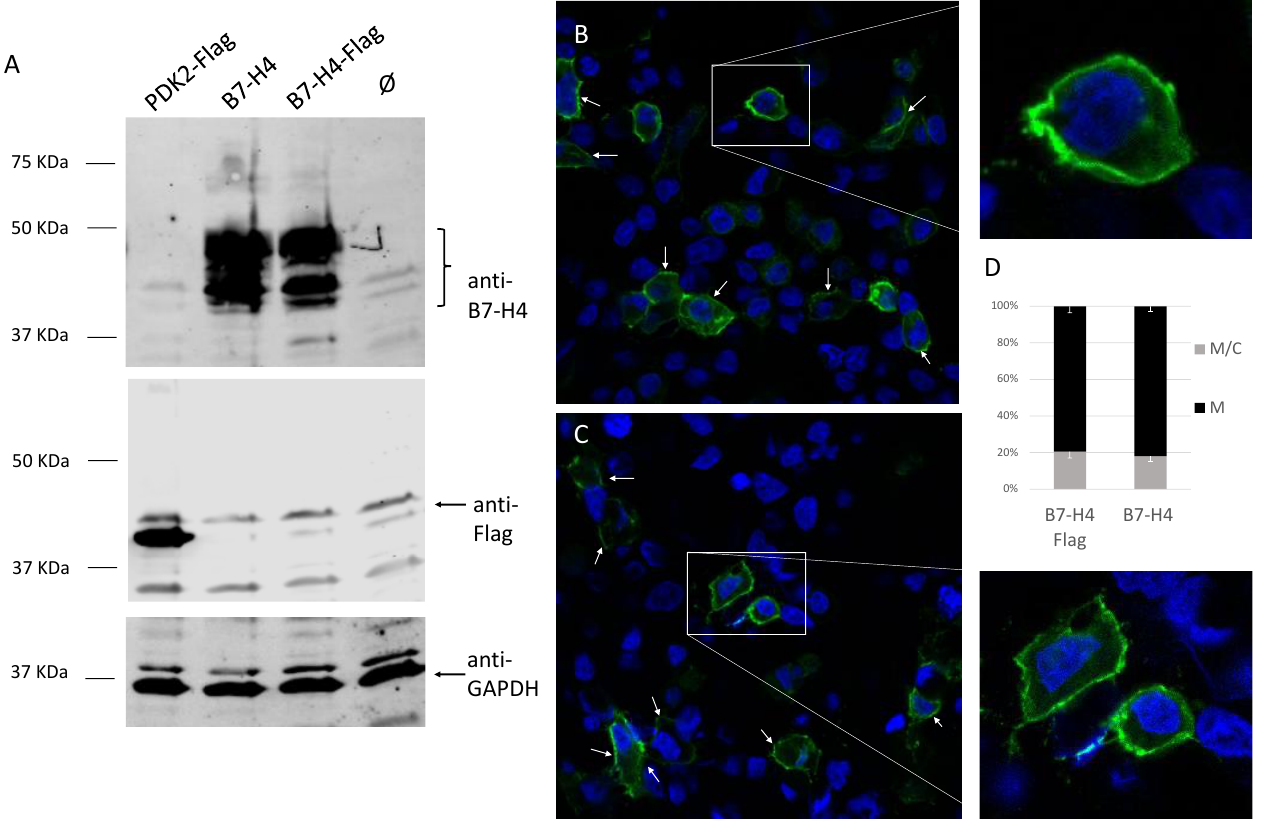
Figure 3. Ectopic overexpression of B7-H4 in HEK293 cells. ( A ) HEK293 cells were transfected with pCDNA3.1 empty vector (Ø) or containing B7-H4 or B7-H4-Flag and processed for Western blot using anti-B7-H4, anti-Flag, and anti-GAPDH antibodies. PDK2-Flag was used as a control for Flag antibody. Molecular weight markers are indicated on the left. ( B , C ) Subcellular localization of B7-H4 and B7-H4-Flag in HEK293 cells. HEK293 cells were transfected to overexpress B7-H4 ( B ) or B7-H4-Flag tag ( C ) and processed for immunofluorescence using anti-B7-H4 antibodies. Nuclei are shown in blue (DAPI staining), and B7-H4 proteins are shown in green (FITC). White arrows high- light membrane immunostaining patterns. Images were taken at 63X. ( D ) Subcellular localization